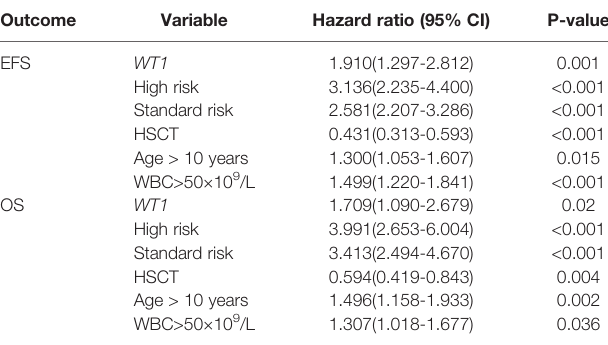
CI, con fi dence interval; EFS, event-free survival; HSCT, hematopoietic stem cell transplantation; OS, overall survival; WBC, white blood cell